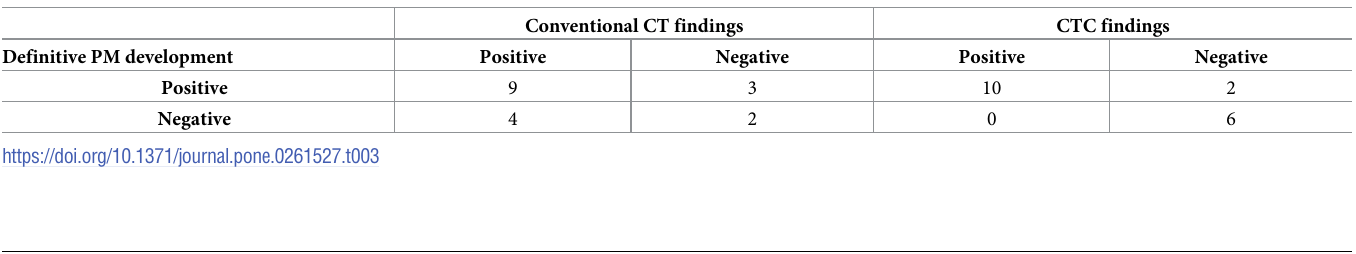
Table 3. Prediction of peritoneal metastasis (PM) development by conventional computed tomography (CT) and CT colonography